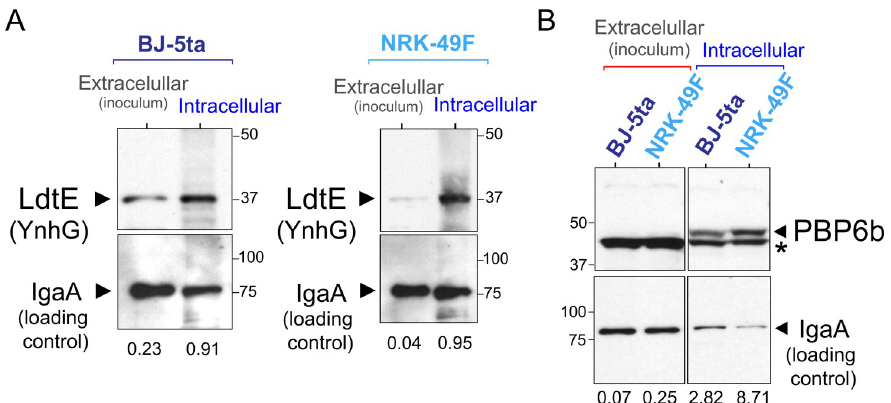
Fig 3. LdtE and PBP6b are up-regulated by non-proliferating intracellular S . Typhimurium. Western blots showing the increased amount of (A) the L,D-transpeptidase LdtE (YnhG) and (B) the D,D-carboxypeptidase PBP6b (DacD) in intracellular bacteria. The inner membrane protein IgaA was used in all cases as loading control. In B, the asterisk indicates a different unrelated tagged protein. The data shown correspond to a representative experiment of a total of three independent biological replicates. Numbers indicate for each sample the ratio between the signal measured by densitometry for the band of the protein of interest versus that of the loading control. Size of molecular weight markers (in kDa) are also